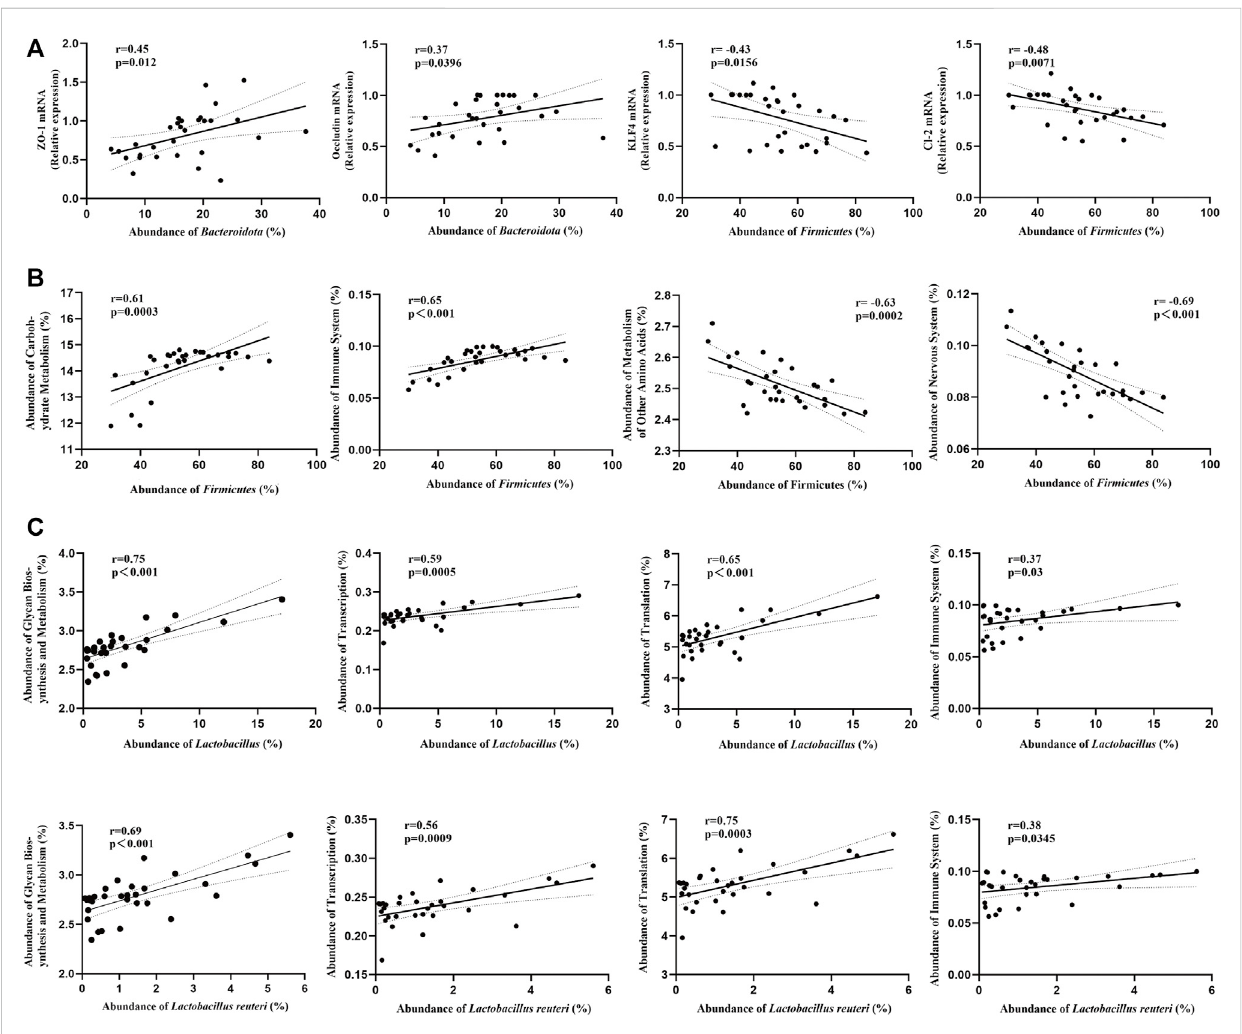
Correlations between gut microbiota and tight-junction proteins/bacterial community ’ s functions (Pearson ’ s r correlation and corresponding p -value) ( n = 8/group). (A) Correlations between gut microbiota (phylum level) and tight-junction proteins mRNA. (B) Correlations between gut microbiota(phylumlevel)andbacterialcommunity ’ sfunctions. (C) Correlationsbetweengutmicrobiota (genus/specieslevel)andbacterialcommunity ’ s